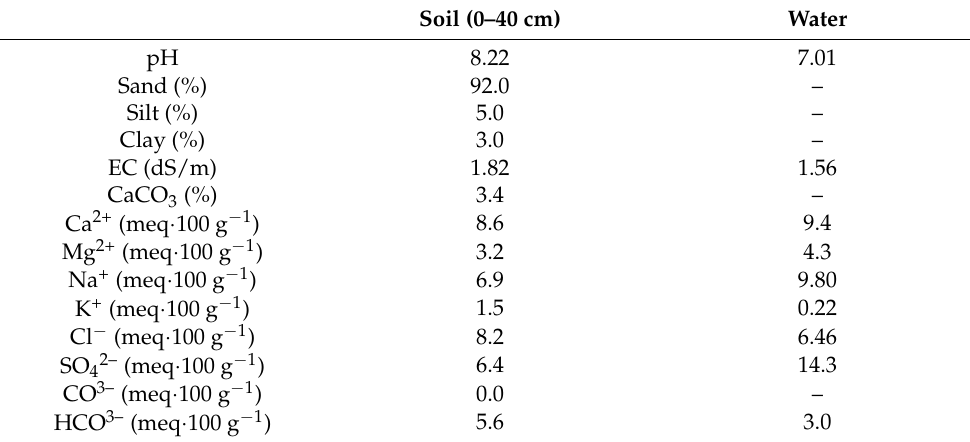
Table 1. Soil and water analysis of the experimental site.